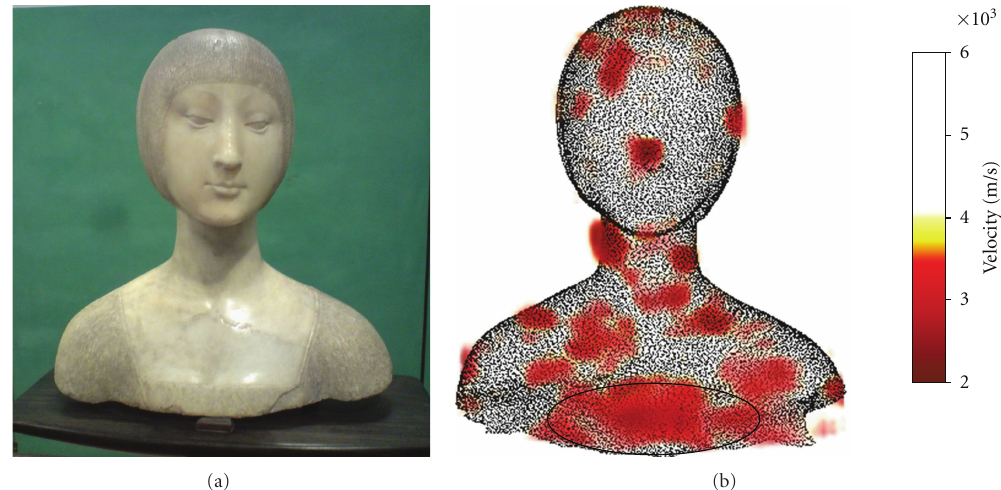
Figure 5: At left the bust of Eleonora d’Aragona (F. Laurana, 1468). At right the frontal 3D image with transparency of the investigated volume showing an area at low velocity, corresponding to the support point of the bust